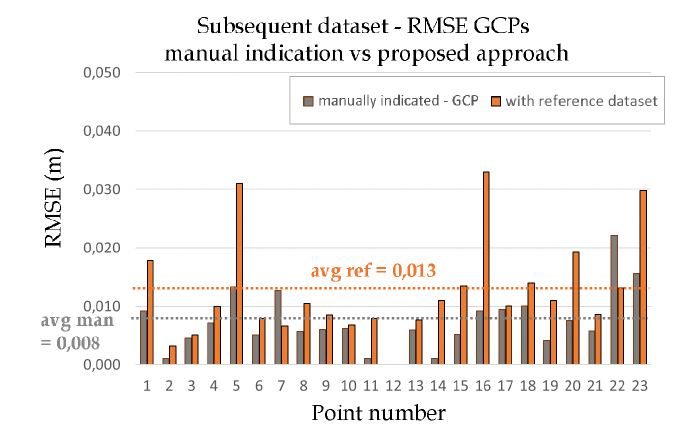
Figure 9. Subsequent datasets—Ground control point RMSEs using the reference module versus obtained through manual indication of the points.